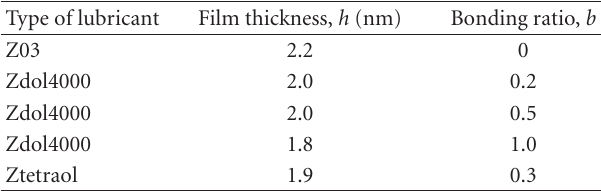
Figure 9: E ff ect of the shearing gap on the viscosity η (cid:4) and elasticity η (cid:4)(cid:4) measured with the Zdol4000 lubricant [24]. Table 2: Samples prepared for the FWM measurements with the thin-film